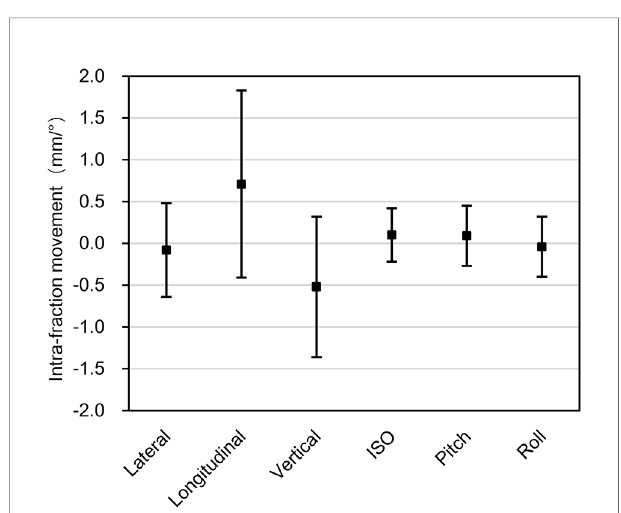
FIGURE 4 | Intra-fraction patient movements. The x-axis represents the three translational directions and three rotational directions, while the y-axis represents the amplitude of the intra-fraction patient movements. The error bars represent the standard